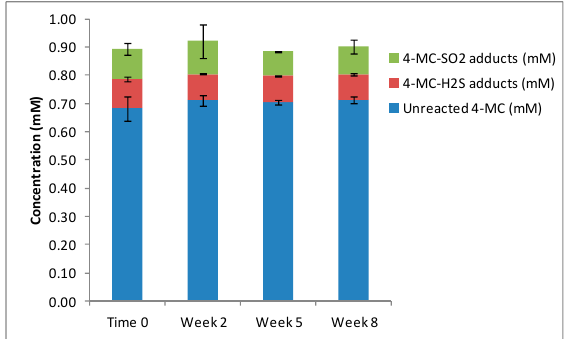
Figure 3. The reaction products measured when 4MBQ was added to model wine containing equimolar concentrations of H 2 S and SO 2 .